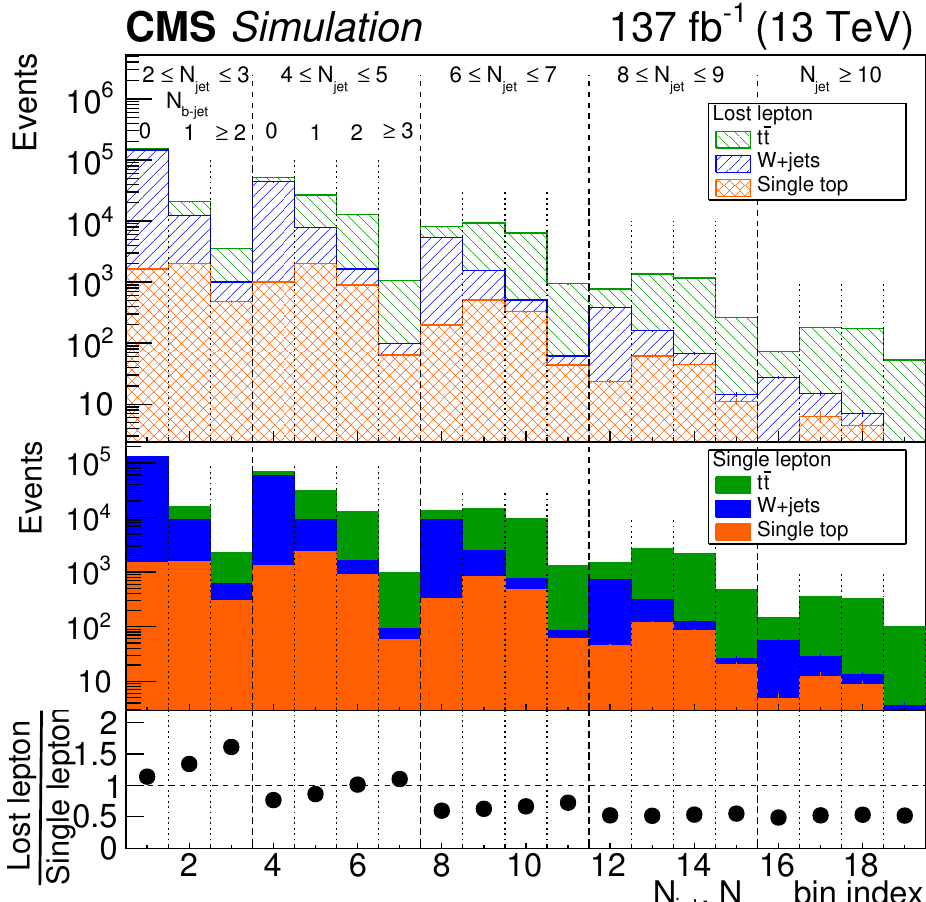
Figure 4 . (Upper) The number of lost-lepton events in simulation, integrated over H as a function of N and N . (middle) Corresponding results from simulation for the number of jet b-jet events in the single-lepton control region. (lower) The ratio of the simulated lost-lepton to the single- lepton results, with statistical uncertainties (too small to be visible). These ratios are equivalent to the transfer factors used in the evaluation of the lost-lepton background, except integrated over H and H miss T T